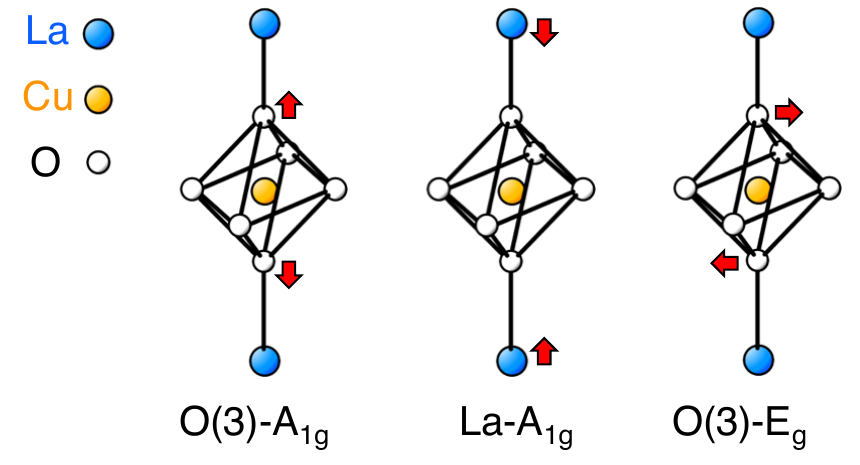
Figure 5: Main optical lattice modes of La pling and which are thought to support hot-phonon physics. Sr is a random substitu- tional atom for La and it is not shown here. La structure with apical-oxygen distance larger than the in-plane